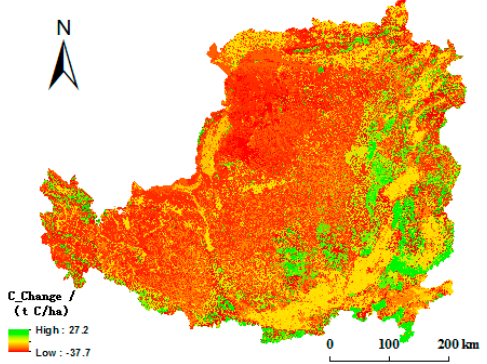
Figure 6. Changes in carbon storage due to changes in carbon density from 2000 to 2010 Table 1. The carbon density of different land use types and changes in carbon density during 2000–2010.